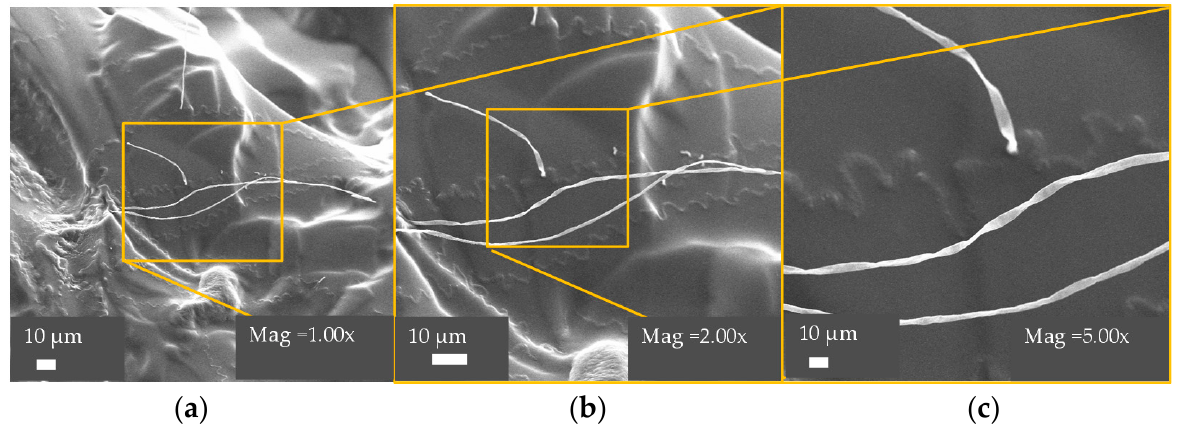
Figure 4. SEM images of Hy05 (2 wt% CNF) samples at ( a ) ×1000, ( b ) ×2000, and ( c ) ×5000 magnifi ‐ cation. Scale bar: 10 μ m.